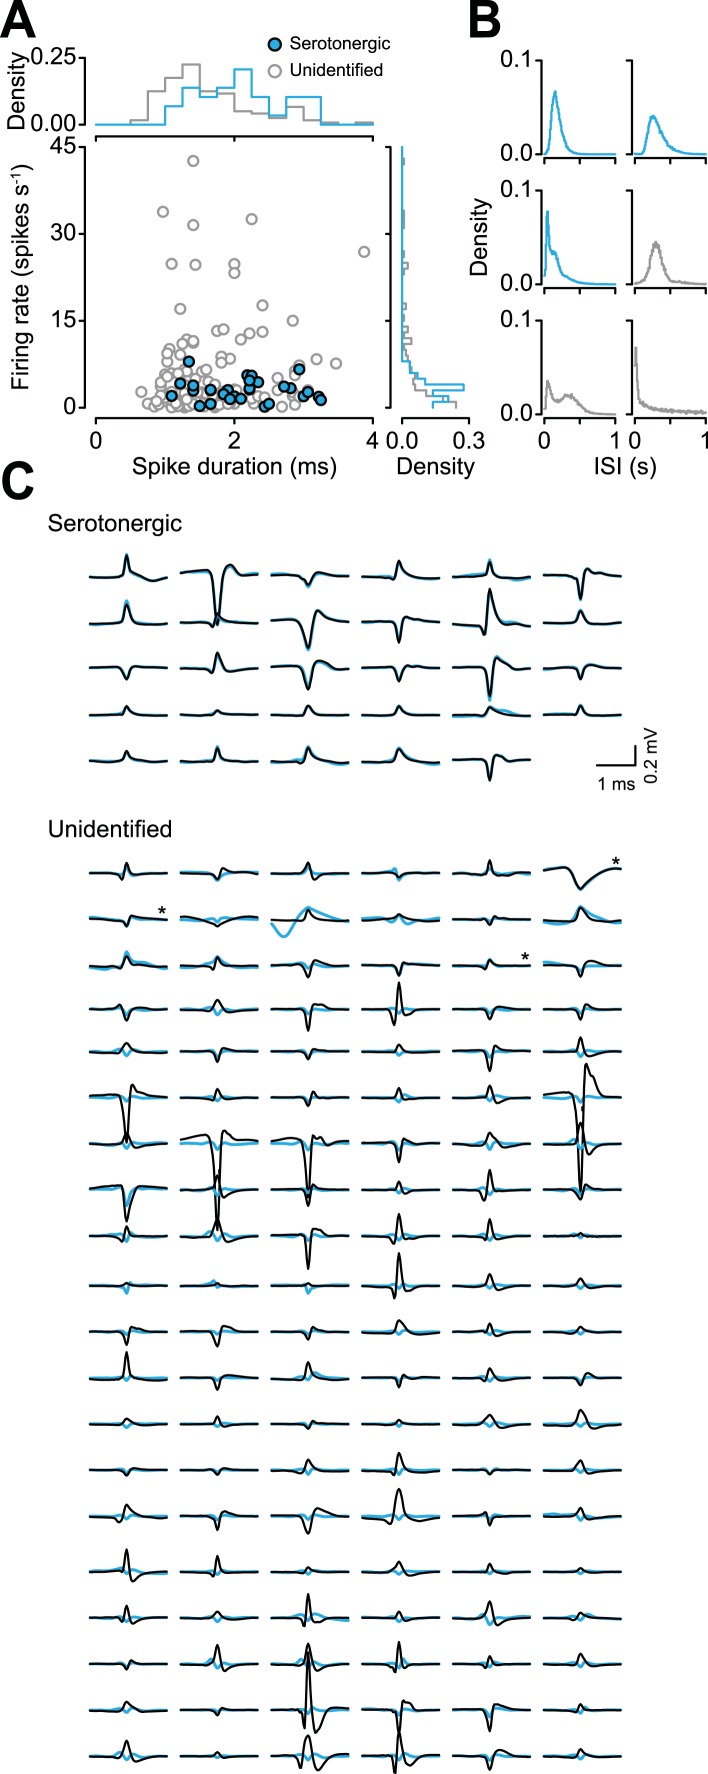
Serotonergic neurons cannot be identified based on firing properties in this data set.(A) Firing rate vs spike duration with marginal density histograms. Serotonergic neurons had significantly longer spike duration than unidentified neurons (Wilcoxon rank sum test, p < 0.05). (B) Example inter-spike interval (ISI) density histograms for three serotonergic neurons and three unidentified neurons. (C) Mean spontaneous spikes (black) and light-evoked voltages (cyan) from all serotonergic and unidentified neurons. Asterisks indicate the three unidentified neurons from the lower-right cluster in Figure 2B.